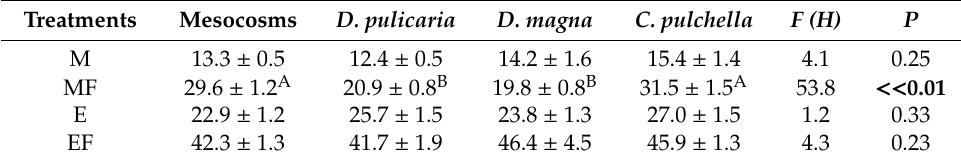
Table 10. Results of one-way ANOVA comparing means ( ± SE) of total chlorophyll concentrations ( µ g L -1 ) for the period of life-table experiments in mesocosms and bottles with D. pulicaria, D. magna , and C. pulchella . E—eutrophic, M—mesorophic, F—fish treatments, F Fisher’s test, and P (significant values are given in bold); means labeled with the same letter are not significantly di ff erent at P < 0.05